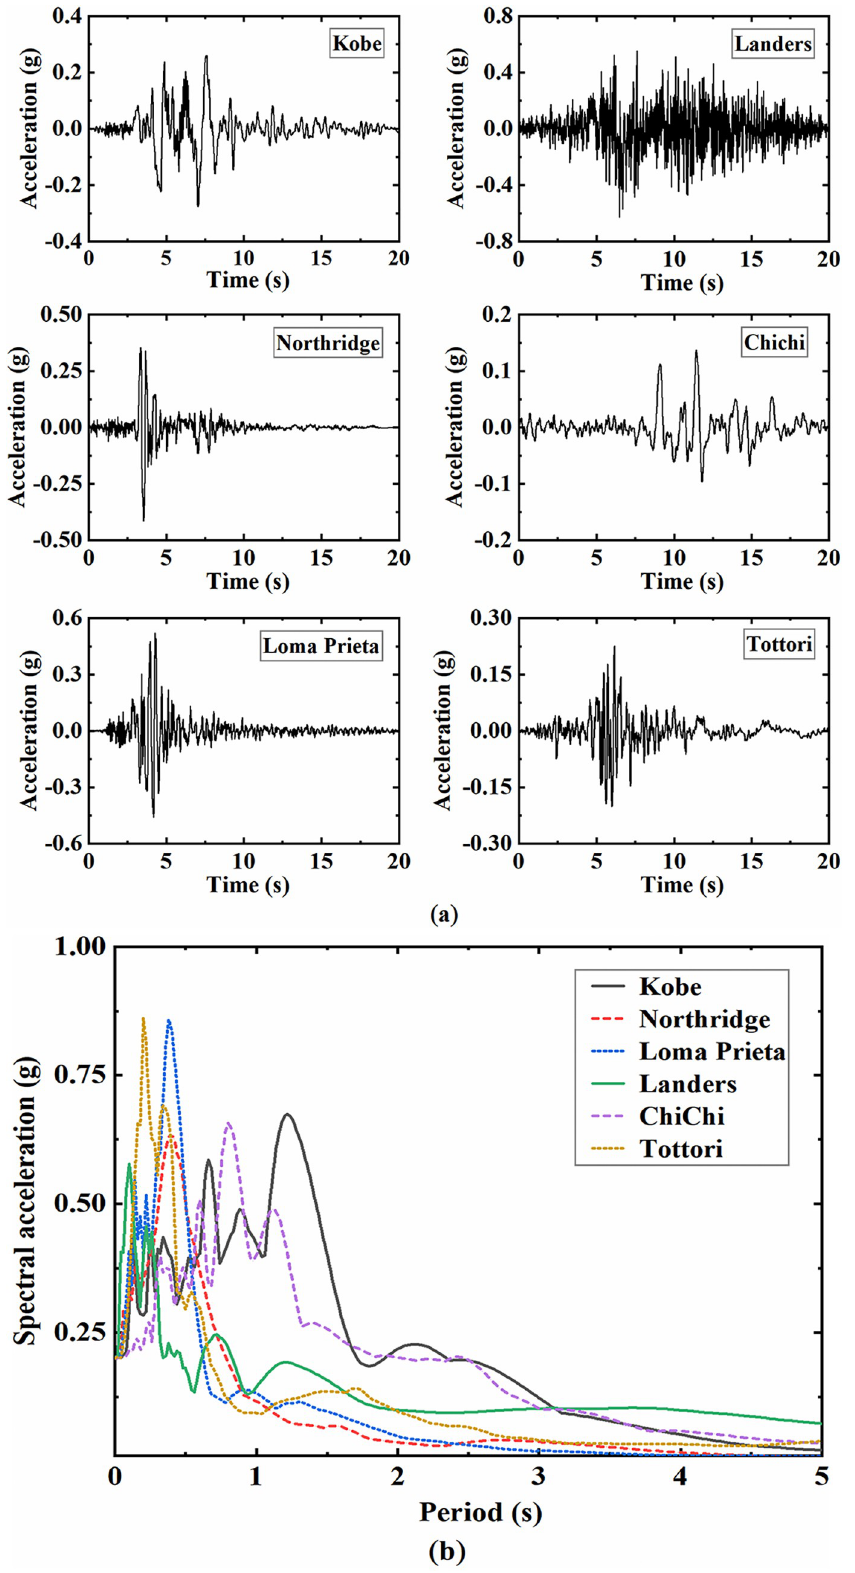
Fig 6. Time-history curves and response spectra of input seismic waves. (a) Time-history curves of acceleration, (b) Acceleration response spectra (with 5% damping and peak acceleration of 0.2g).